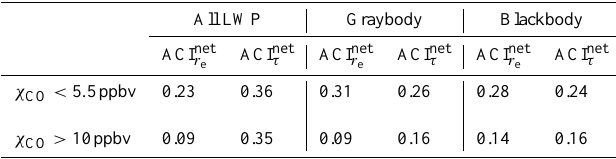
Table 4. ACI net parameter calculated for the optical depth and the effective radius considering all clouds, graybody clouds, and black- body clouds, for two different regimes of CO concentration repre- senting lower and upper quartiles of CO concentration.